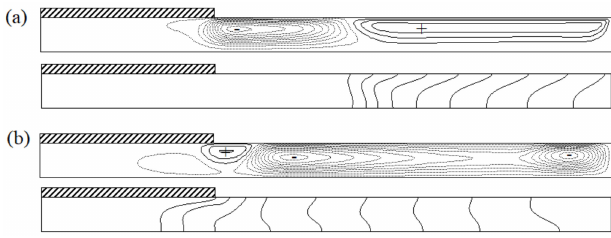
Figure 6. Streamlines and concentration distribution at θ = 0 ( a ) and θ = π / 4 ( b ) when Re T =